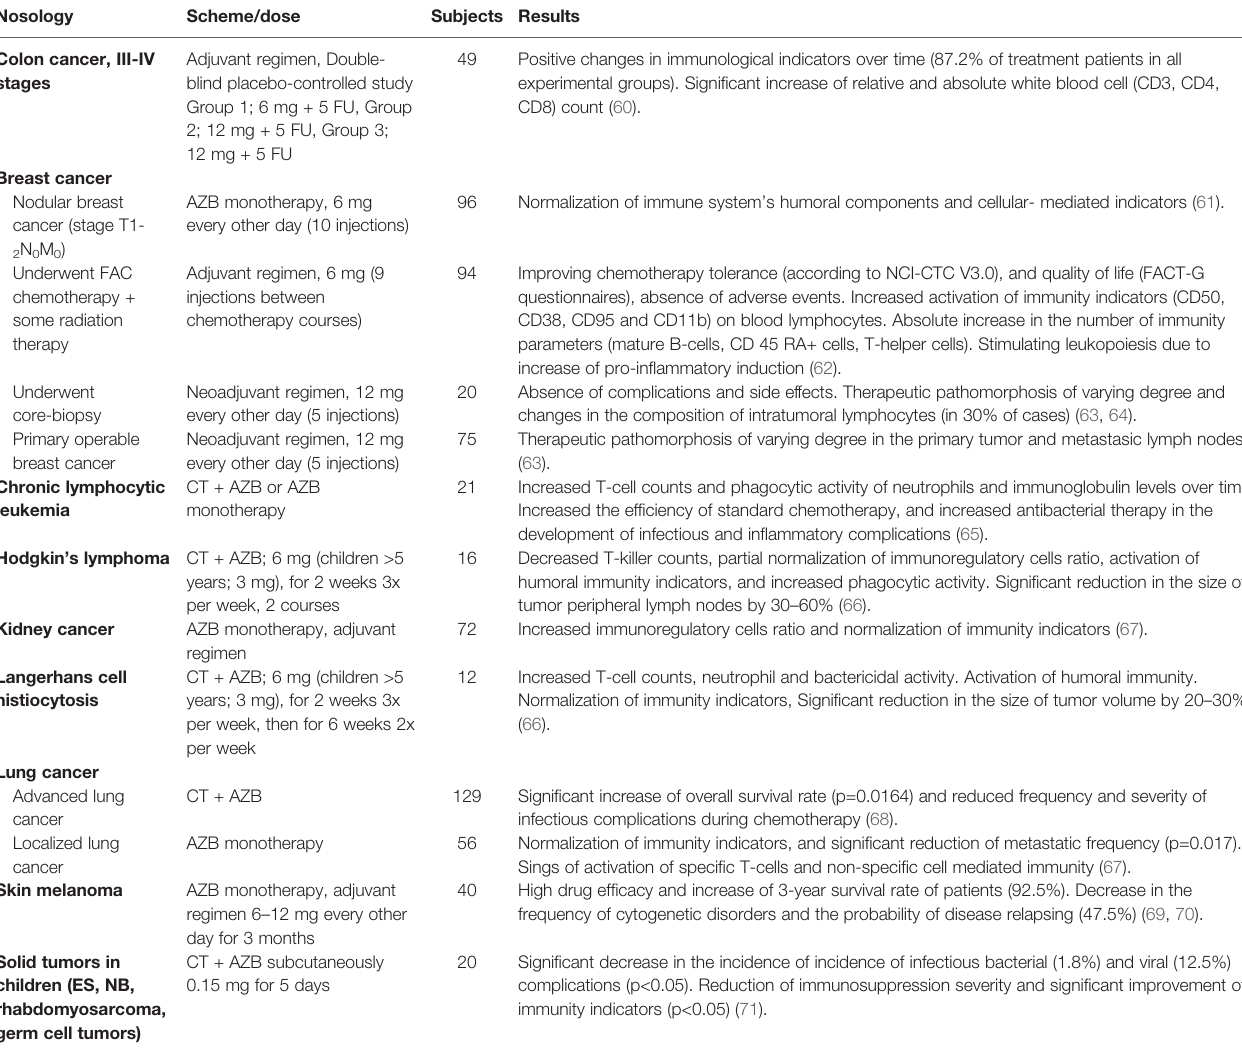
TABLE 1 | Oncology Studies with Azoximer bromide. Nosology Scheme/dose Subjects Results Colon cancer, III-IV stages